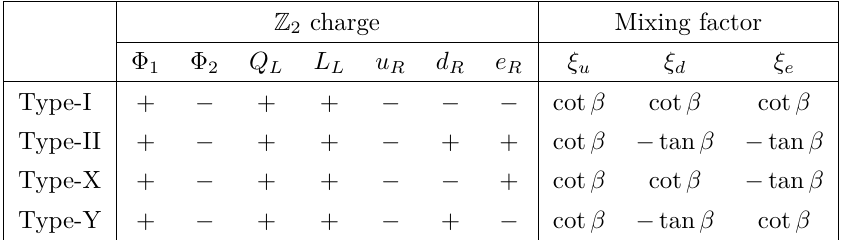
Table 1 . Charge assignment of the softly-broken Z 2 symmetry and the mixing factors in Yukawa